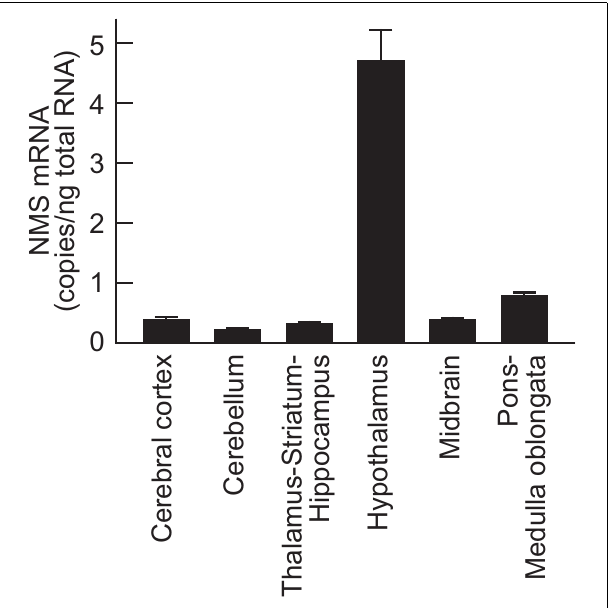
FIGURE 5 | Expression of neuromedin U receptors types 1 (NMUR1) and 2 (NMUR2) mRNA in rat brain. Rat NMUR1 (closed bars) and NMUR2 (open bars) mRNA were quantified by quantitative reverse transcription–polymerase chain reaction analysis. Data represent means ± SEM of three